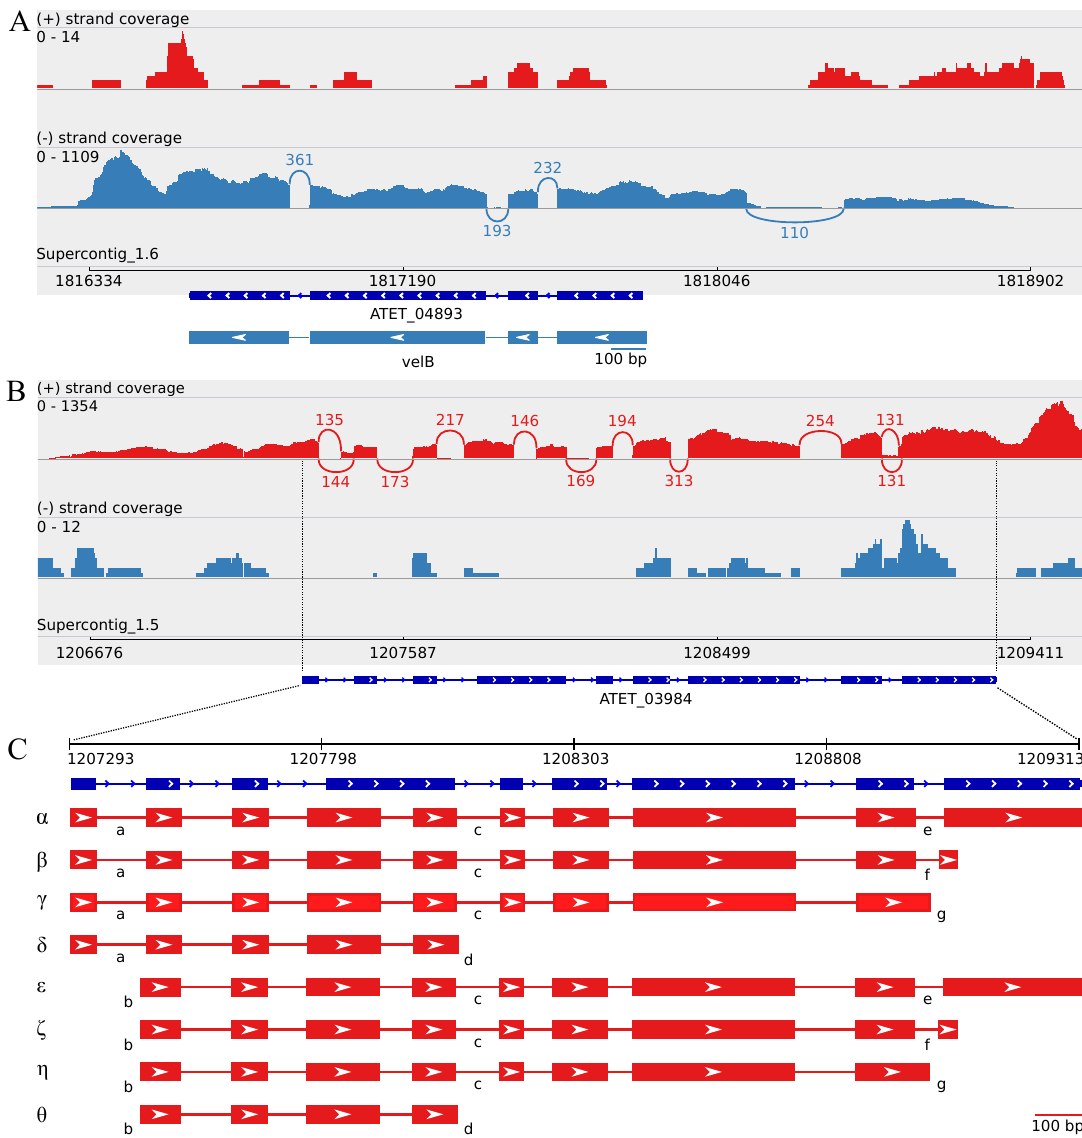
Figure 4. The transcript structure of velB ortholog and splice variants of vosA ortholog. Sashimi plots of ( A ) the velB ortholog and ( B ) the vosA ortholog describing the strand-specific alignment coverage of the read sequences of A. terreus MUCL 38669 over the corresponding genomic regions of NIH2624. The curved splice junctions represent the number of spliced reads, indicating an intron at that specific location. ( C ) An enlarged figure of the splice variants of the vosA ortholog as indicated by the Sashimi plot ( B ). The boxes represent the exons; the arrow heads indicate the genomic strand of the transcript; and the lines represent introns. The apparent alternative splicing of vosA ortholog occurs at three locations with the following approximate proportions of the number of indicative reads: a, 52%; b, 48%; c, 91%; d, 9%; e, 40%; f, 40%; and g, 20%; resulting in eight putative splice variants of vosA : alpha ( α ), beta ( β ), gamma ( γ ), delta ( δ ), epsilon ( ε ), zeta ( ζ ), eta ( η ) and theta ( θ